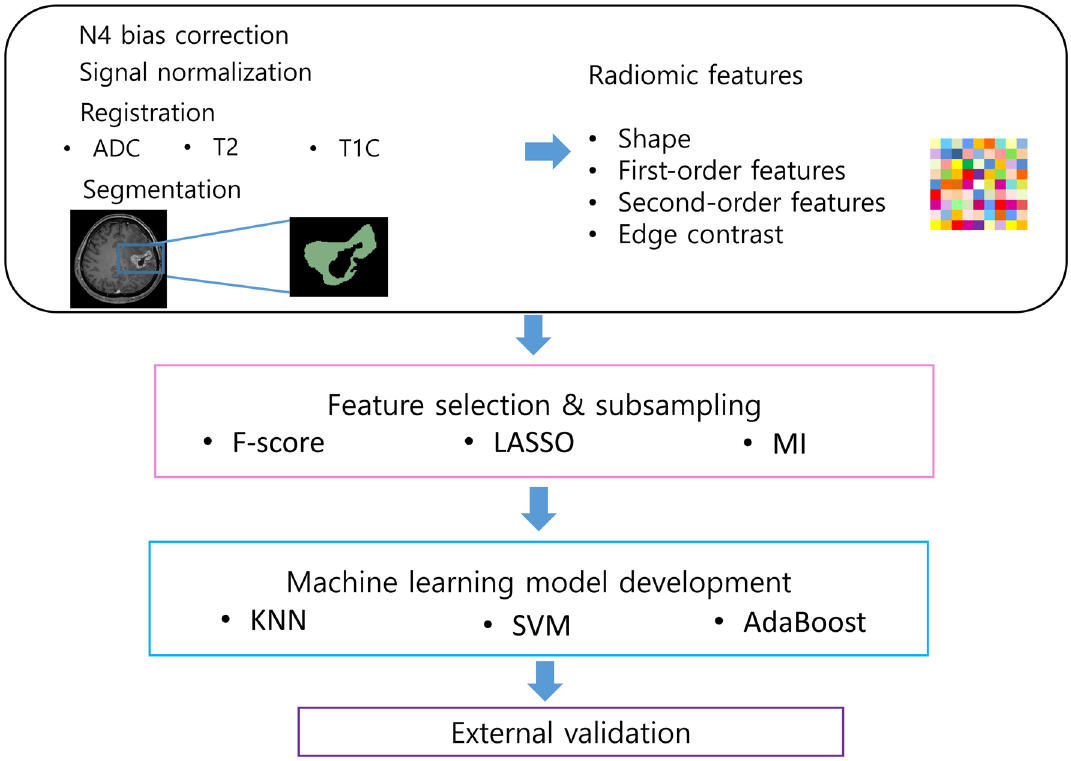
Figure 2. The radiomics pipeline of our study. KNN k-nearest neighbors, MI mutual information, LASSO least absolute shrinkage and selection operator, SVM support vector machine, T1C postcontrast T1WI, T2